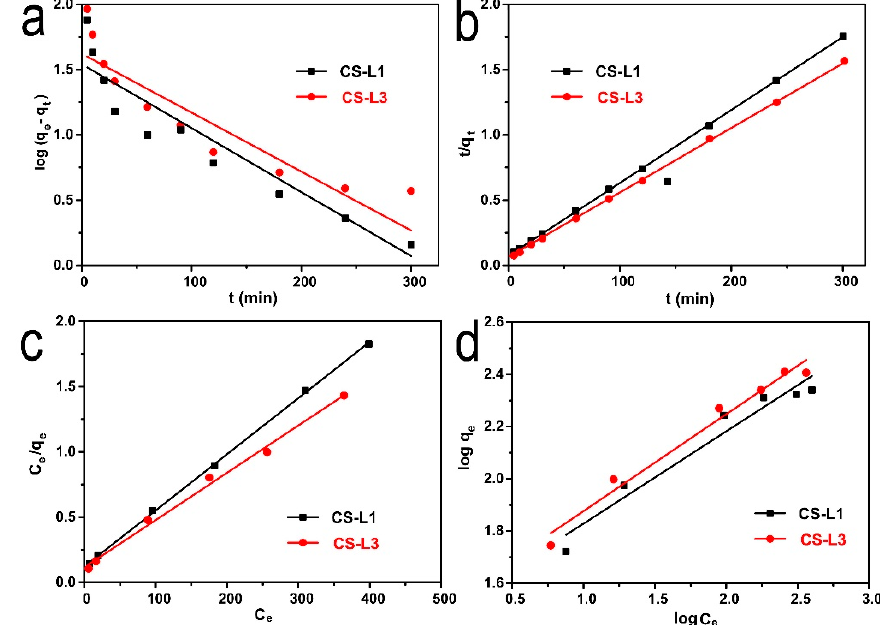
Figure 9. Fits of models for adsorption of Cu(II) onto CS membranes: ( a ) pseudo-first-order model, ( b ) pseudo-second-order model, ( c ) Langmuir model and ( d ) Freundlich model.